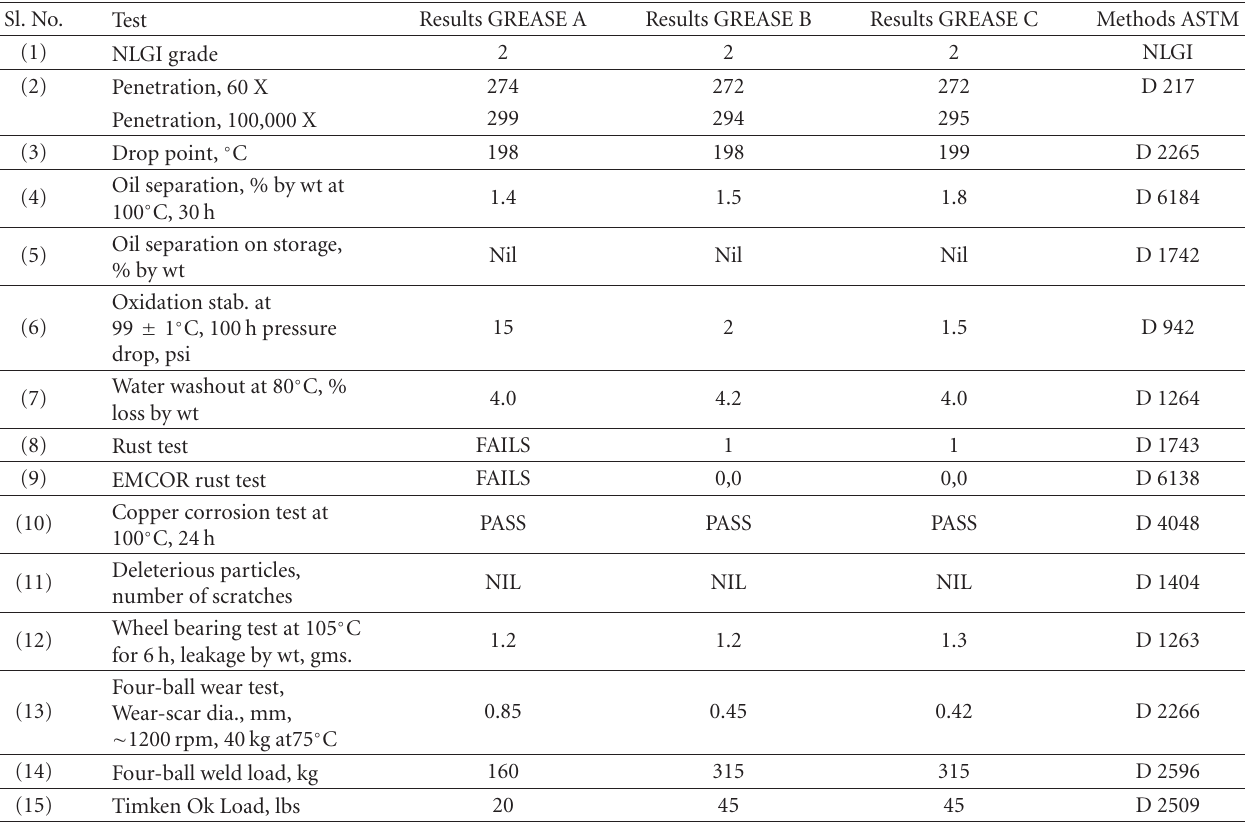
Table 3: Typical test results recorded for the prepared Grease A, Grease B, and Grease C. Sl.